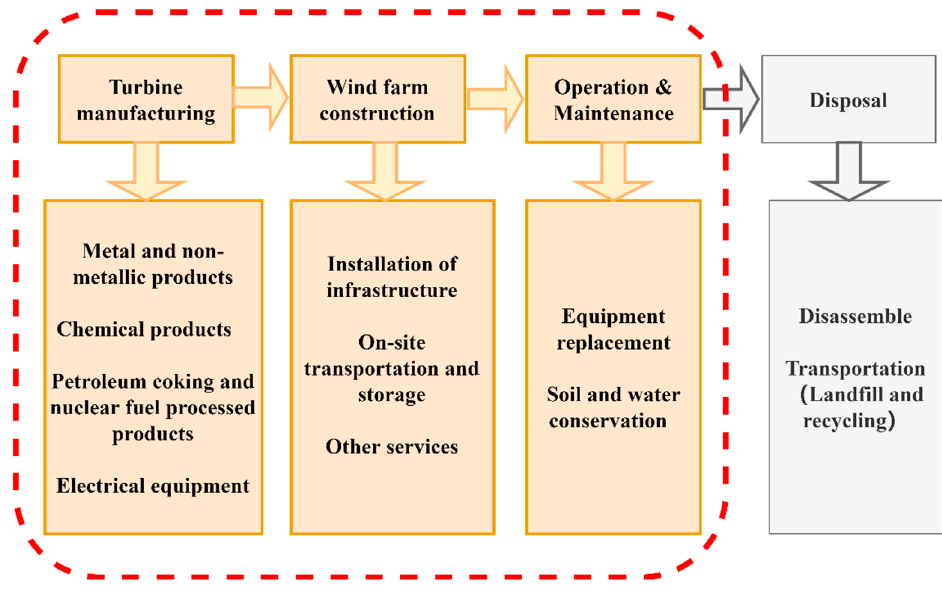
Figure 2. System